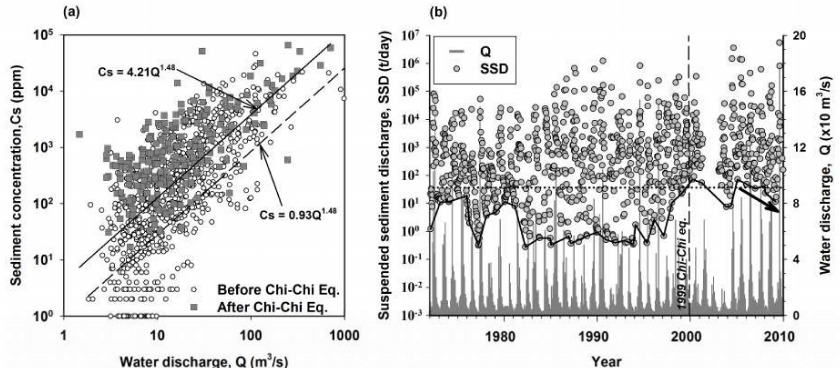
Figure 2. ( a ) The Cs–Q relationships before and after the 1999 Chi-Chi earthquake in the Chenyoulan River. ( b ) Variation of suspended sediment discharges in the Chenyoulan River. The thick black line represents the lower boundary of suspended sediment